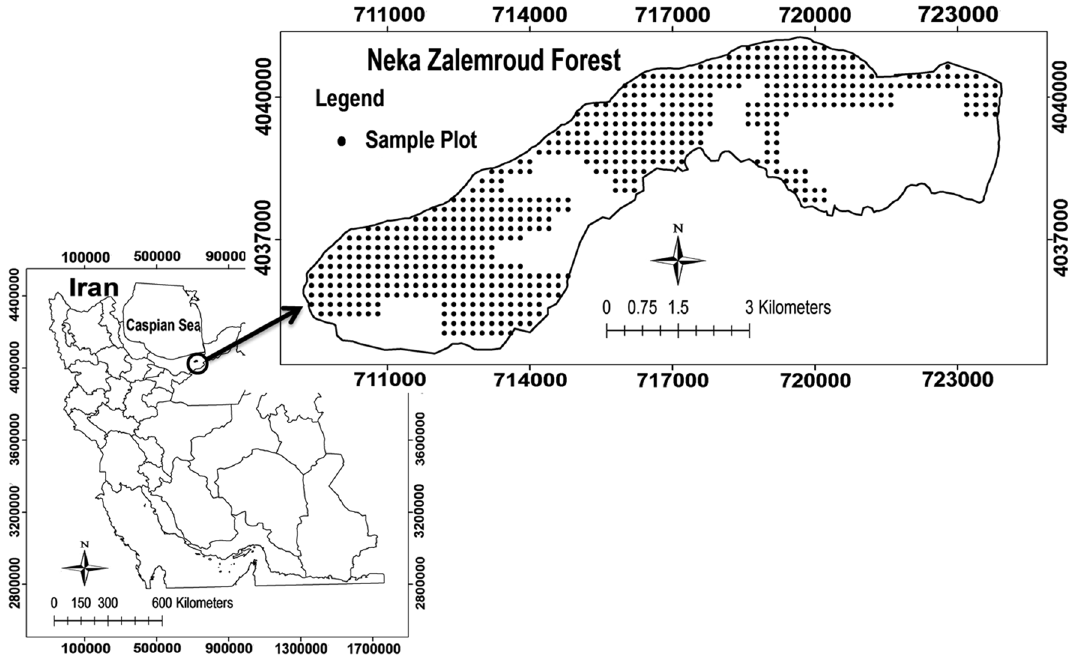
Figure 1. The location of study area and sample plots (QGIS 3.12.0, https